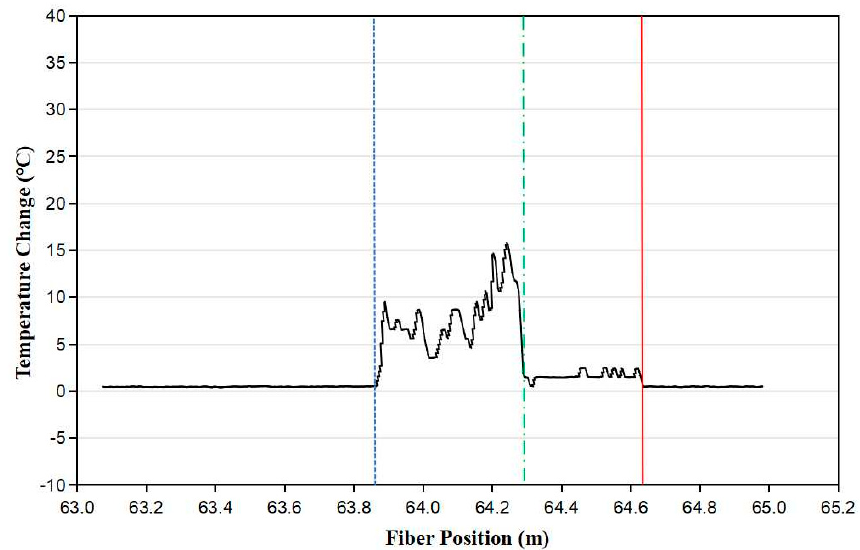
Figure 3. The sensor clearly distinguished the boundary between the liquid nitrogen and nitrogen vapor. The dashed green line indicates the boundary between the nitrogen vapor and liquid, which was located at ~64.30 m with reference to the original point of the OBR4400 unit. The sensing fiber was located between the dotted blue line and the solid red line.